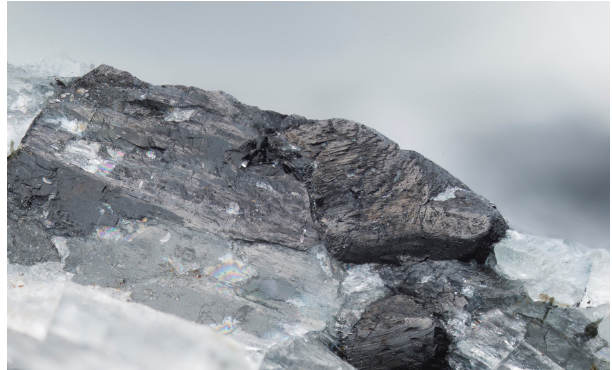
Figure 2. Zinkgruvanite crystals in the type specimen. Field of view is 8 × 5mm. Catalogue number GEO-NRM 20170502. Photo: Tor- björn